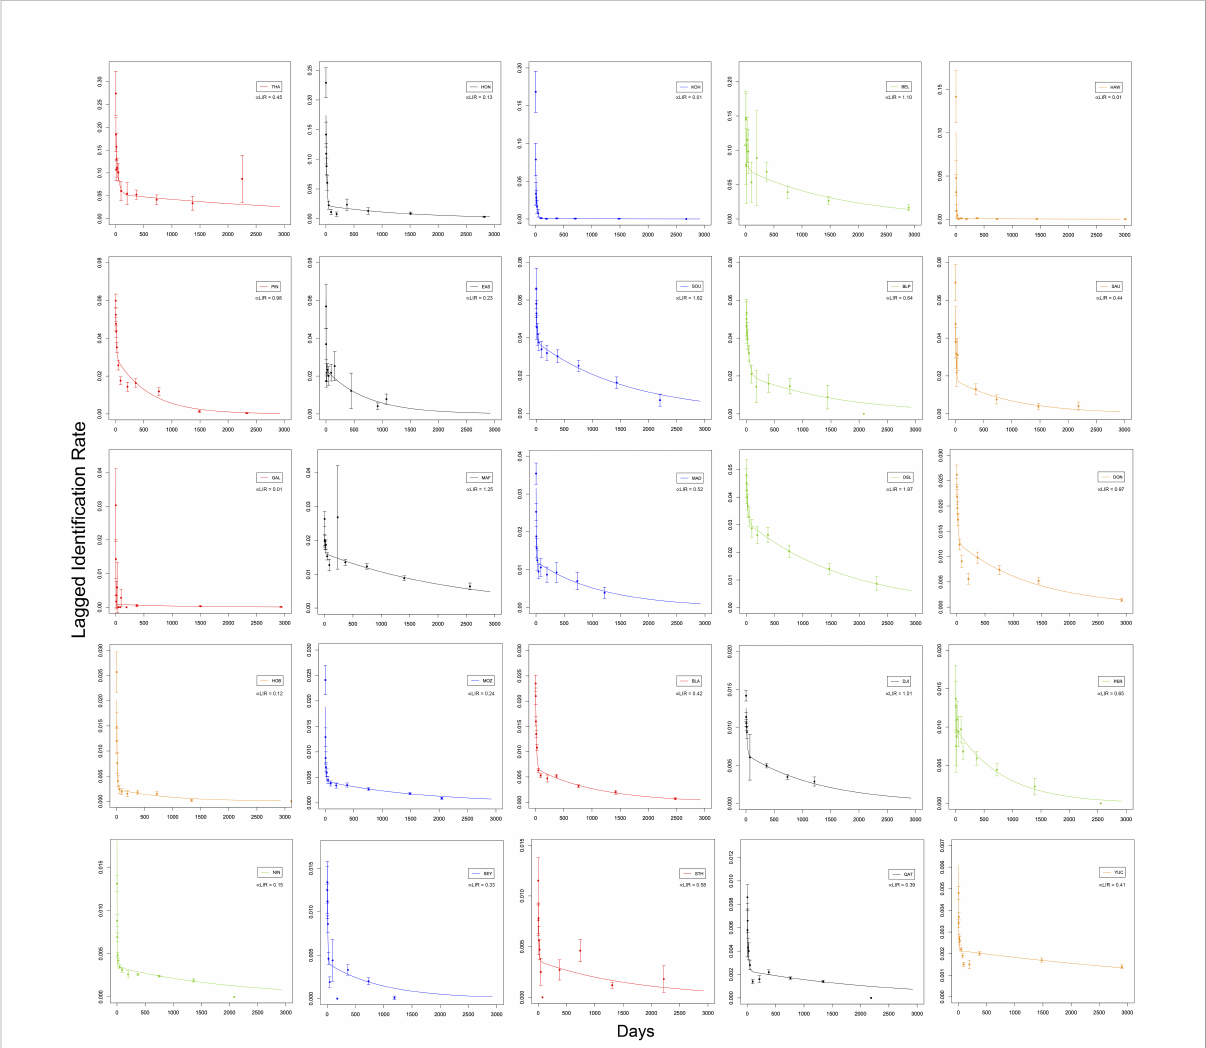
FIGURE 3 Lagged Identi fi cation Rate, the probability of resighting individual whale sharks at the study site after a certain time lag, for all 25 study sites with fi tted formula (exp(- a4*td )/ a1 )*((1/ a3 )+(1/ a2 )*exp(-(1/ a3 +1/ a2 )* td ))/(1/ a3 +1/ a2 ) from model H (see Table 3), where a1 = population size, a2 = residency time in, a3 = residency time out, a4 = mortality rate and td = time lag. ∝ LIR is the ‘ LIR residency proportion ’ calculated a2 / a3 , where a larger value correlates with longer adjusted residency at the study